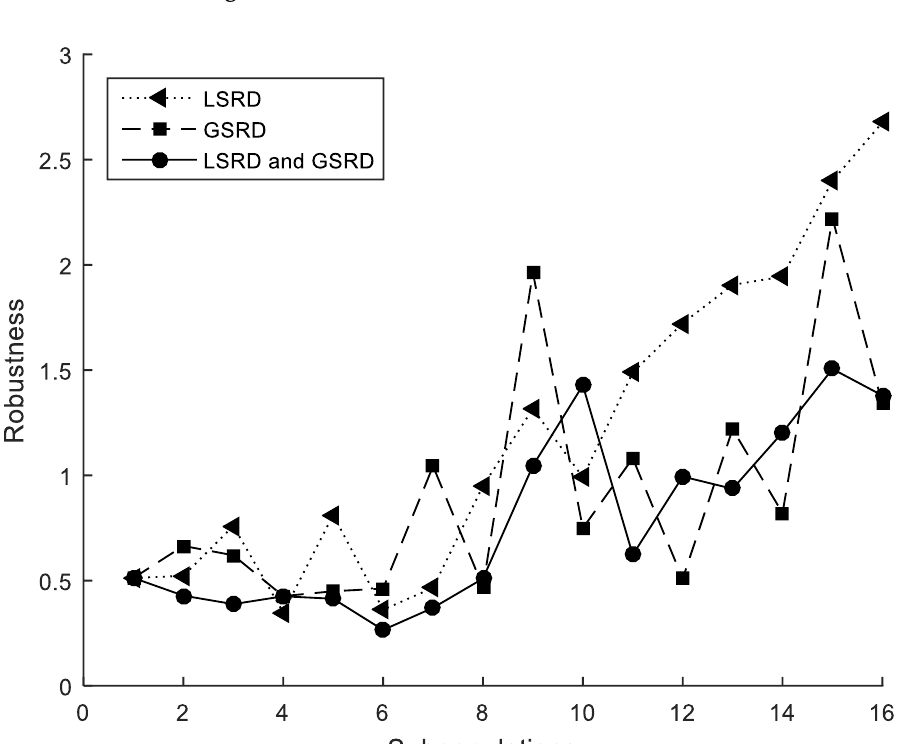
Figure 6. Cross-section under flexure. Robustness.